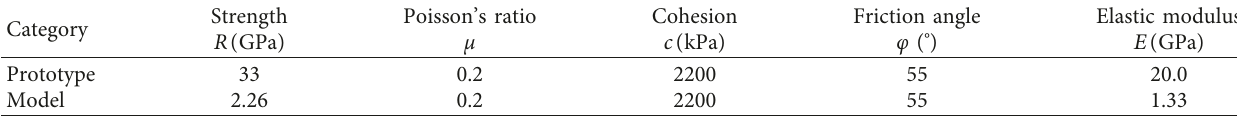
Table 3: Lining physical parameters of the model and